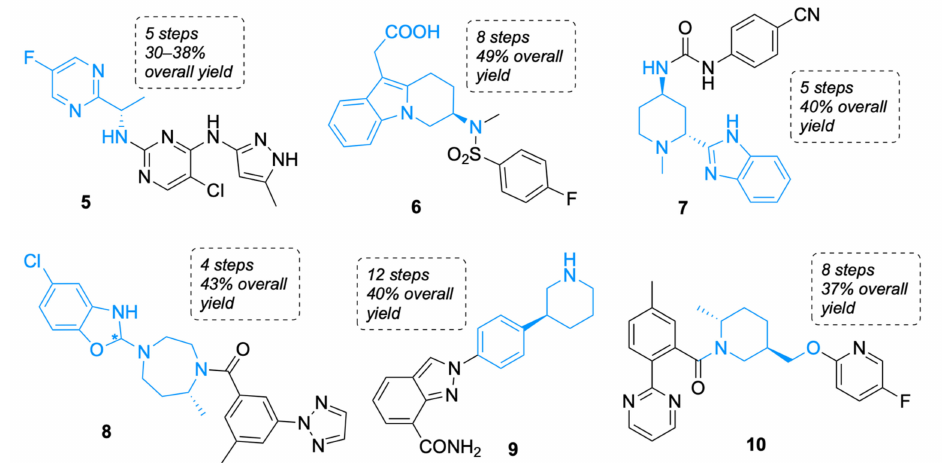
Figure 2. APIs produced by chemoenzymatic manufacturing processes. The portion of the API’s skeleton colored in blue was involved in the biocatalytic step. * The asterisk in structures indicates center of asymmetry here and in any further